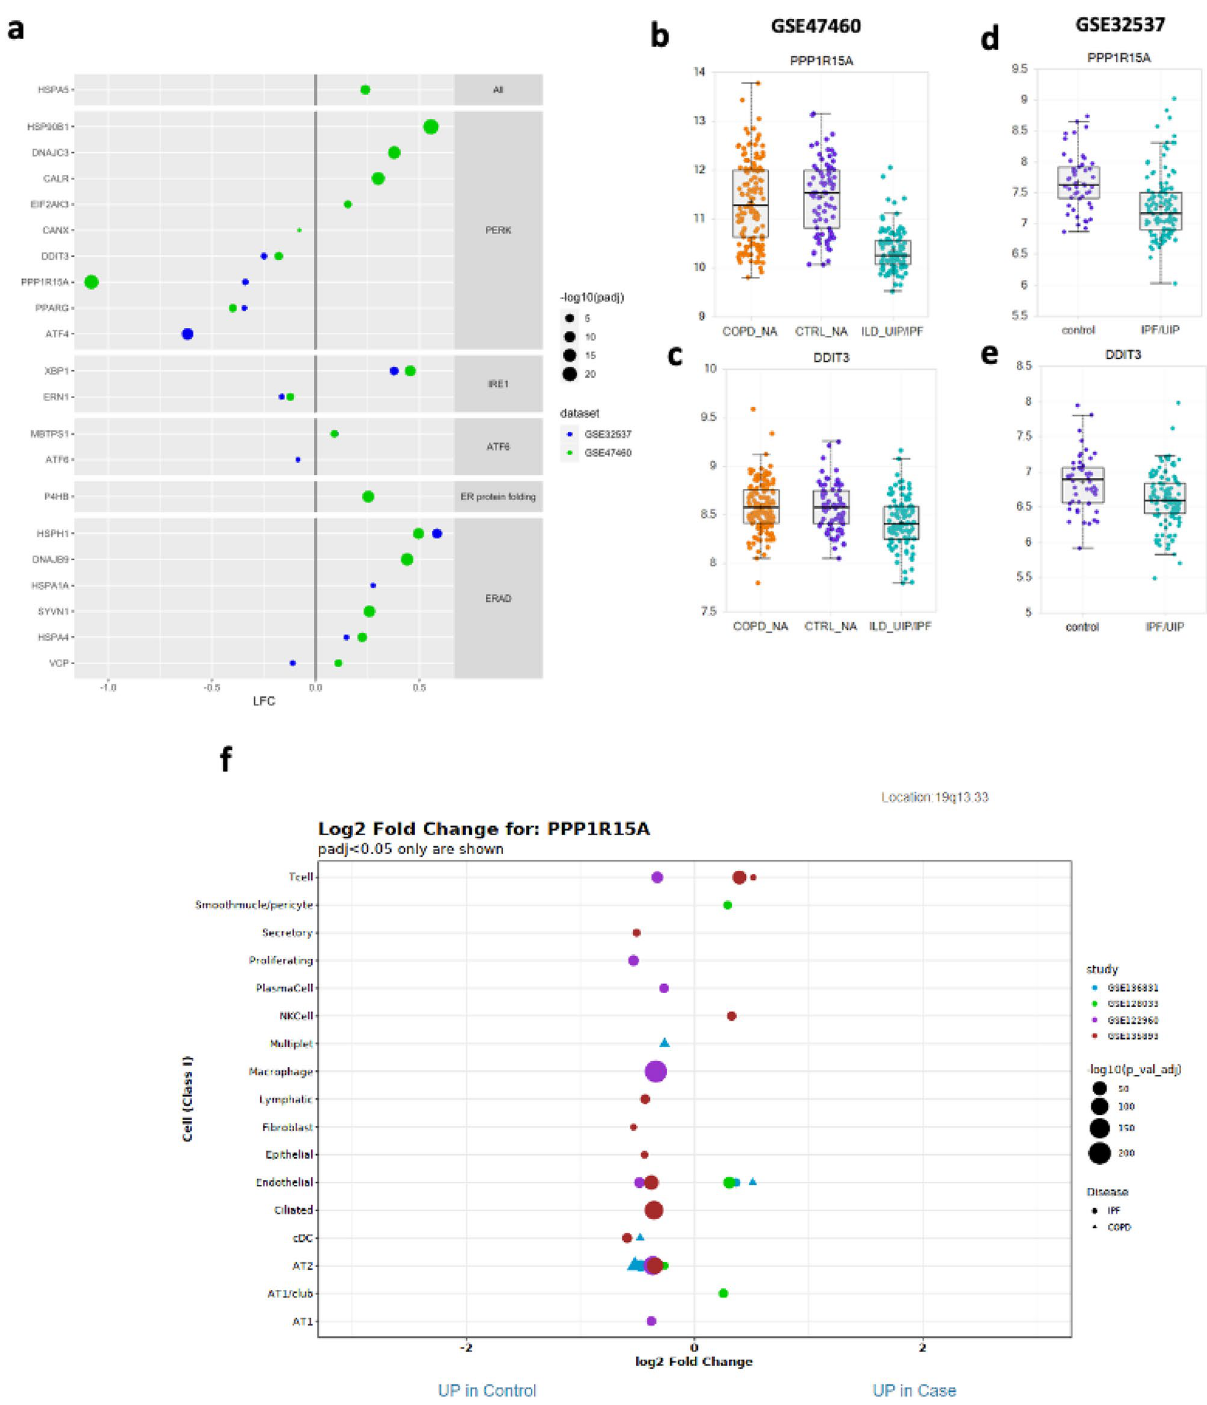
Figure 1. Altered expression of UPR genes in IPF lung tissues. ( a ) Plot illustrating IPF versus healthy control differential expression for 2 large cohort studies (GSE32537 (blue) and GSE47460 (green) for UPR genes; x-axis is log2 fold change (LFC), the size of the bubble indicates the − log10 FDR adjusted P-value (padj). The genes shown are grouped by pathway (shown to right, also in Table S1). While the majority of UPR genes are up-regulated in IPF lung compared to control, most of the genes in the ATF4 pathway, including PPP1R15A, are down-regulated in IPF. Genes shown but with no bubble displayed have data present but are not significant at FDR adjusted P-values < 0.1. ( b – e ) Boxplots of PPP1R15A and DDIT3 for the 2 cohort studies, where GSE47460 shows the expression of control and IPF/UIP samples ( b , c ) while GSE32537 also includes samples from COPD as well as control and IPF lung tissue ( d , e ). ( f ) Plot showing the differential expression of PPP1R15A across multiple cell types based on single cell RNA sequencing data. Cell types are listed on the y-axis and the log2 fold change for PPP1R15A for each cell type from each study (individual bubble) is on the x-axis. Legend for bubble colour and size is on the righ of the plot. Only samples with adjusted P-values < 0.05 are shown on the